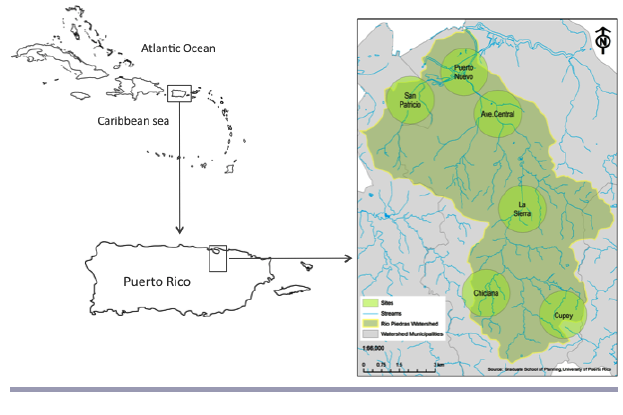
Fig. 1 . Locations of six of the thirteen sampling locations across the Río Piedras watershed that were studied by San Juan ULTRA.